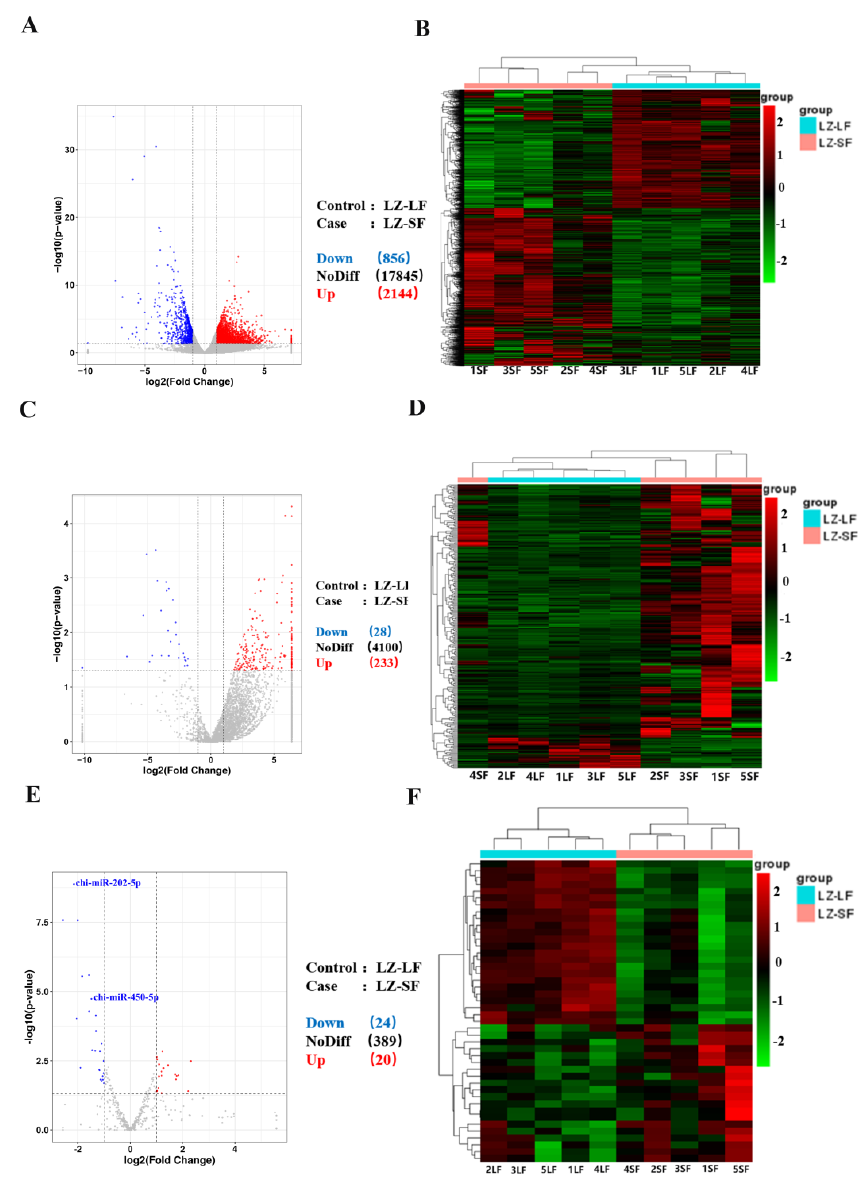
Figure 1. Volcano map and cluster analysis of DEmRNAs, DElncRNAs, and DEmiRNAs. Volcano plots of DEmRNAs ( A ), DElncRNAs ( C ) and DEmiRNAs ( E ); Cluster analysis plots of DEmRNAs ( B ), DElncRNAs ( D ) and DEmiRNAs ( F ).